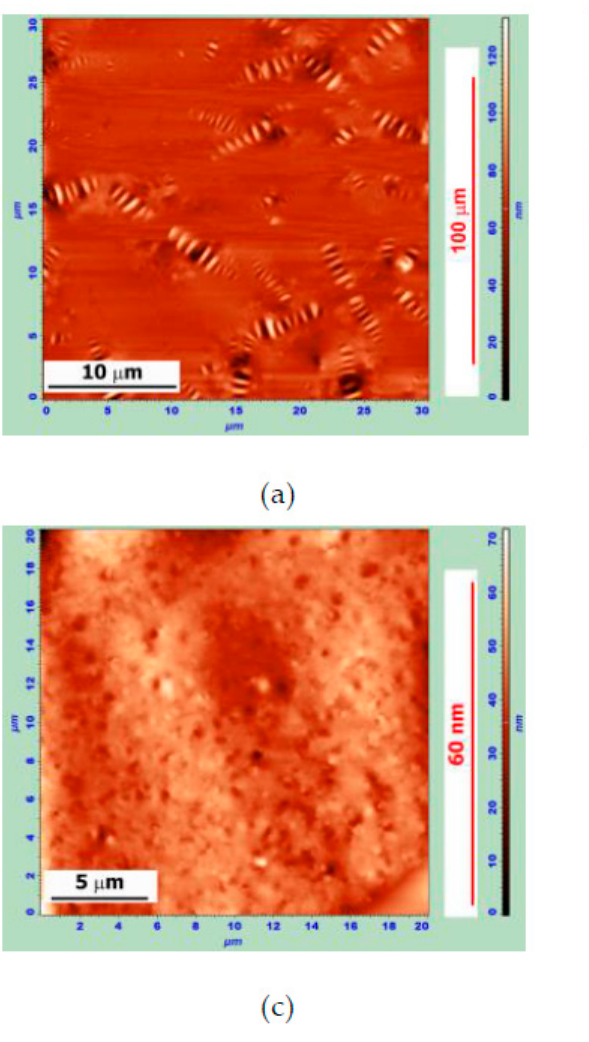
Figure 1. AFM images of the surface topography of ( a ) the sample of Bit-A, obtained 2 days after sample preparation (30 × 30 μ m, Z-coordinate—130 nm); ( b ) the sample of MB of 90 wt.% Bit-A+ 10 wt.% APDDR, obtained 2 days after sample preparation (8 × 8 μ m, Z-coordinate—190 nm); ( c ) the sample of MB of 80 wt.% Bit-A+ 20 wt.% APDDR obtained 1.5 months after sample preparation (20 × 20 μ m, Z-coordinate—70 nm).